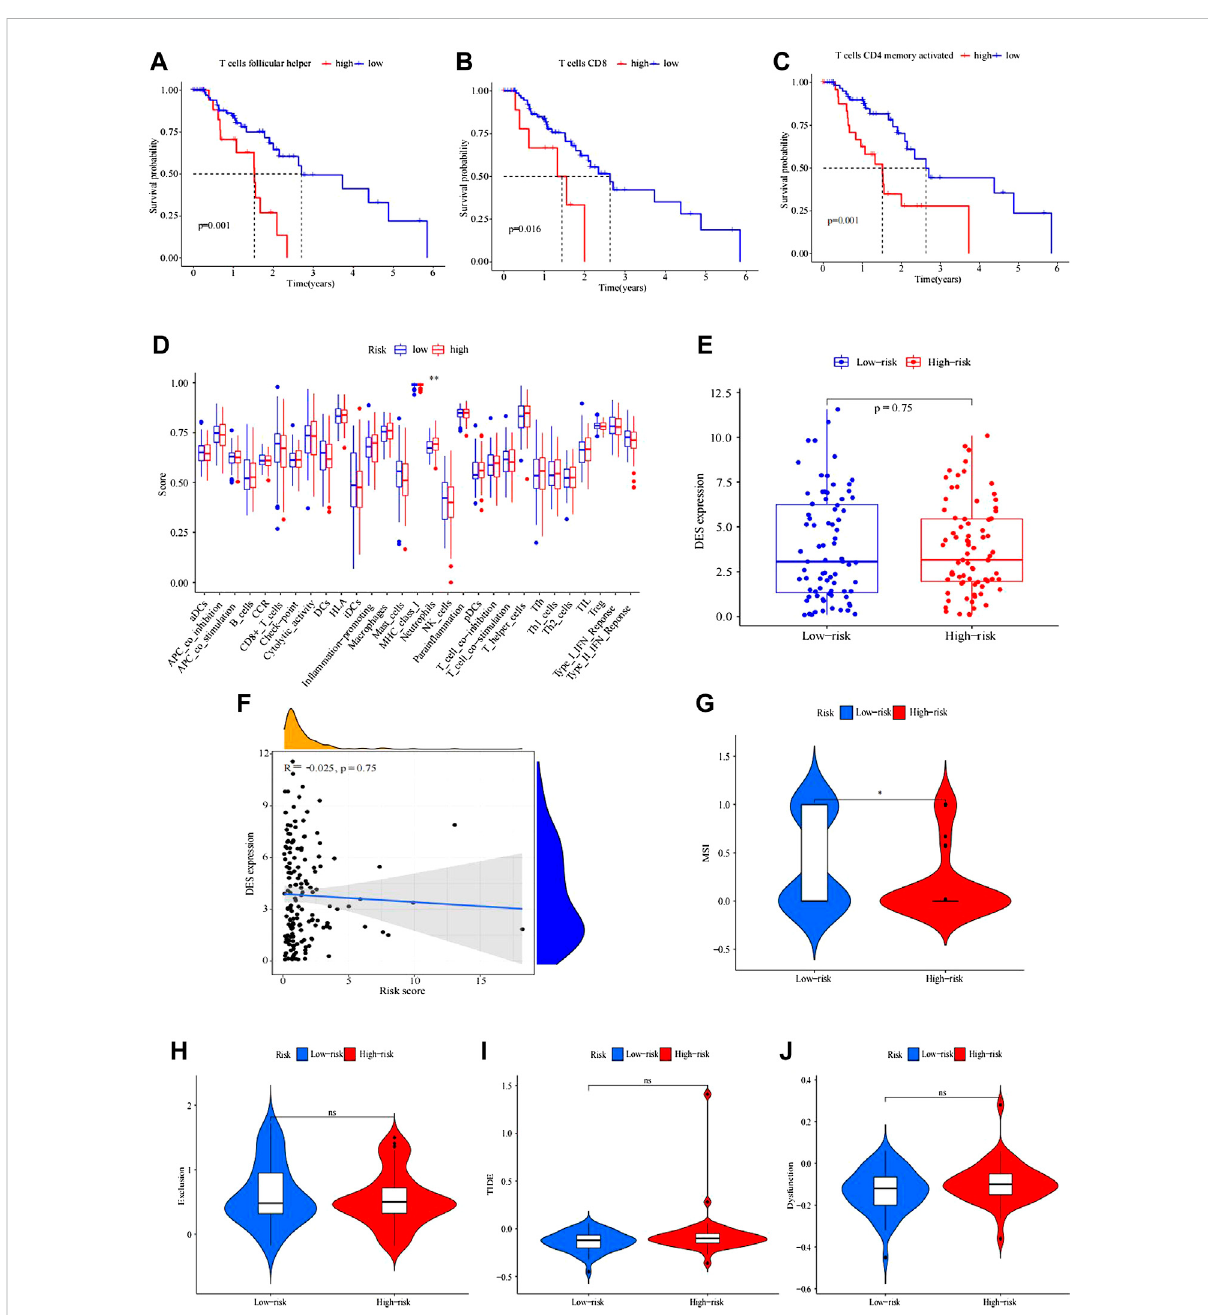
FIGURE 5 Kaplan – Meier survival analysisof immune-related cells inIRGPI subgroups. (A – C) Differences in follicular helper T cells between IRGPI subgroups. (B) CD8TcellsweredifferentbetweenIRGPIsubgroups. (C) CD4memory-activatedTcellsdifferedbetweentheIRGPIsubgroups( p < 0.05). (D) Molecular-and immune-related functions of different IRGPI subgroups. The molecular- and immune-related gene sets of the IRGPI were analyzed by single-sample gene setenrichmentanalysis(ssGSEA),andthedifferencesbetweendifferentIRGPIsubgroupswerecompared.ScatterpointsrepresentthessGSEAscoresof the two subgroups. Thick lines indicate median values. The bottom and top of the box are the 25th and 75th percentiles (quartile range), respectively. Signi fi cant differences between the two subgroups were tested by the Wilcoxon test (NS: not signi fi cant, * * * p < 0.05, p < 0.01, *** p < 0.001). Analysis of mutationloaddifferenceinthetumor. (E – F) BoxplotofdifferencesintumormutationloadbetweenhighandlowIRGPI. (F) Correlationtestanalysisofpatient riskscoreandtumormutationburden.( p =0.023,R=0.18)ImmuneescapeandimmunotherapyofTIDE,MSI,exclusion,anddysfunctionscoreindifferent IRGPI subgroups. (G – J) Violin plot of exclusion between the IRGPI subgroups. (H) Violin plot of dysfunction between the IRGPI subgroups. (I) Violin plot of MSIbetweentheIRGPIsubgroups. (J) ViolinplotofTIDEscoresbetweentheIRGPIsubgroups.ThescoresbetweenthetwoIRGPIsubgroupswerecompared through the Wilcoxon test (ns, not signi fi cant; *, p < 0.05; ***, p <